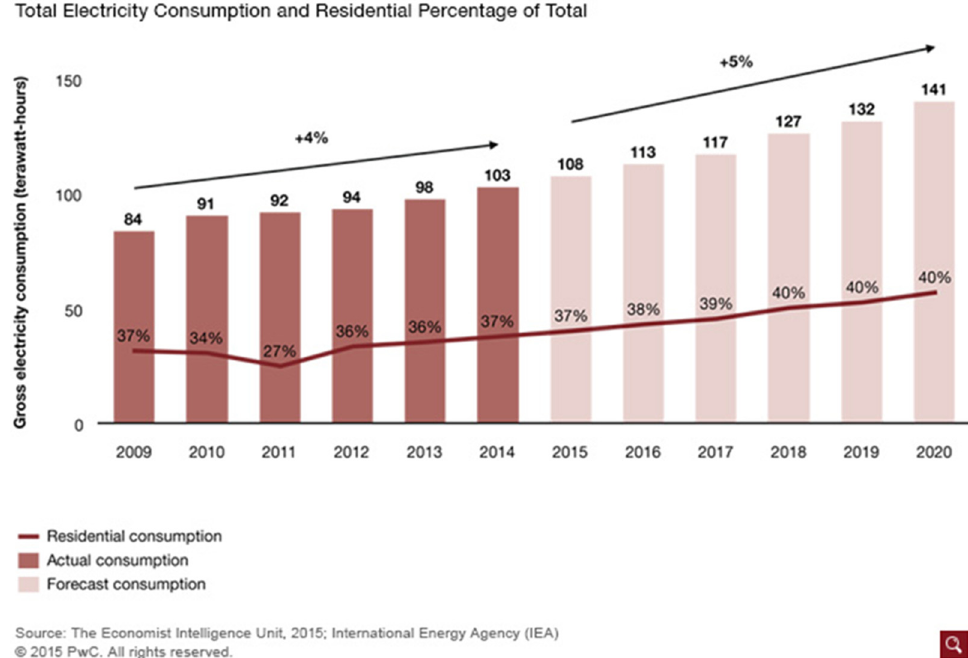
Fig. 10. Total electricity consumption, with the residential percentage of total